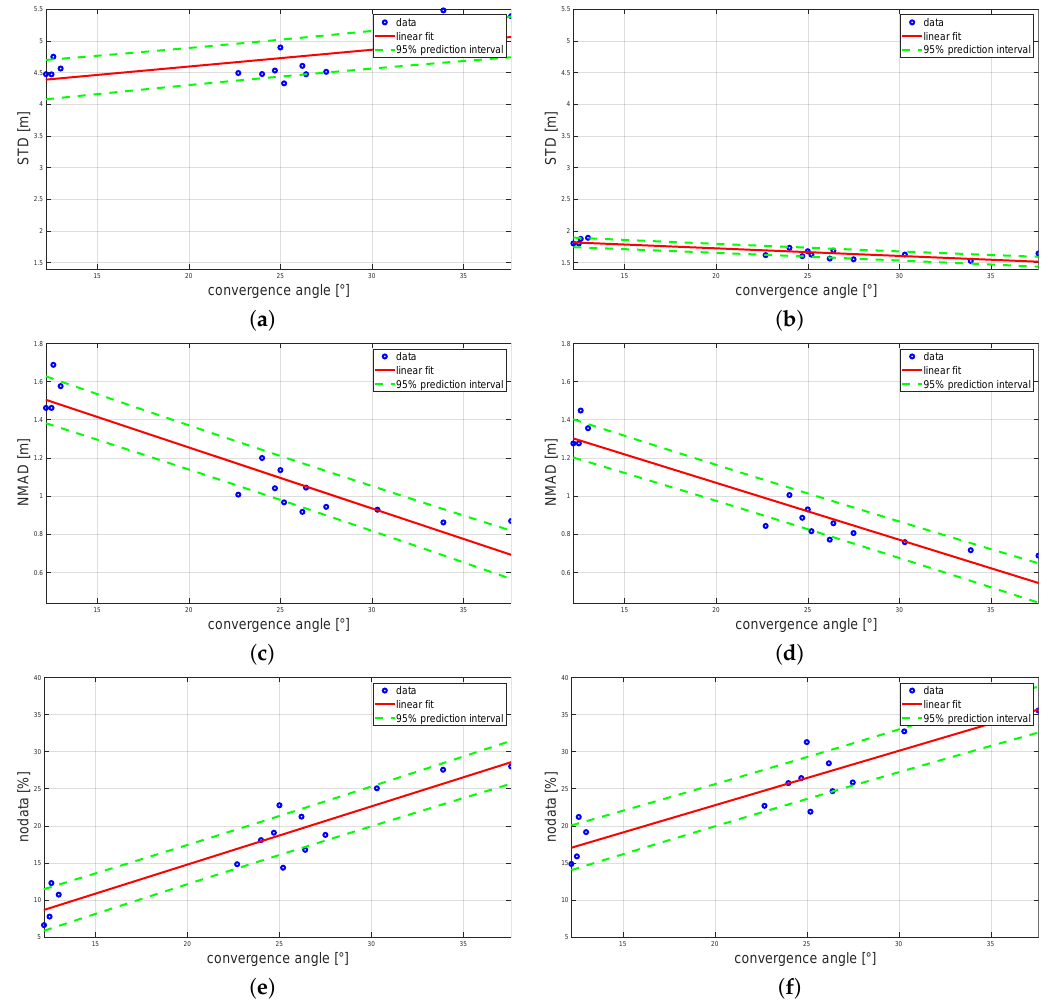
Figure 23. Plots showing ( a , b ) STD, ( c , d ) nmAD and ( e , f ) percentage of nodata values plotted versus the convergence angle for the Ljubljana test site. ( a , c , e ) are based on the complete error distribution, while ( b , d , f ) is based on a clipped distribution, where all gross outliers with an absolute value larger than 6 m are